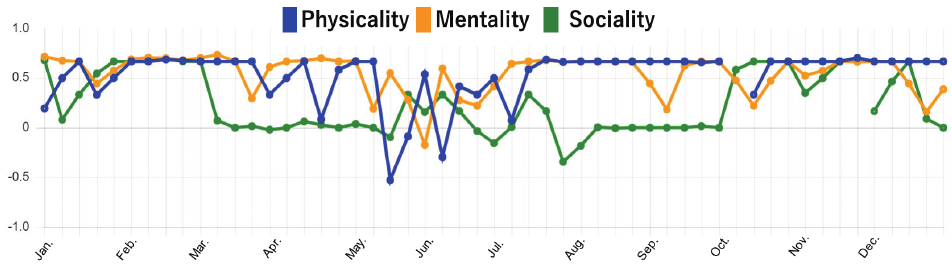
Figure 6. Self − evaluation results of subject A in the period of this experiment.